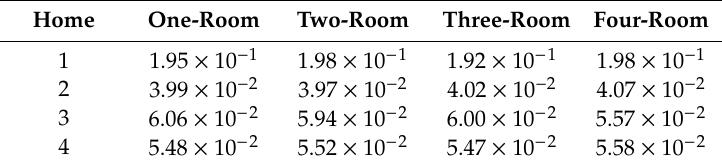
Table 7. Summary of average residuals ( δ ) (K) for experimental data.